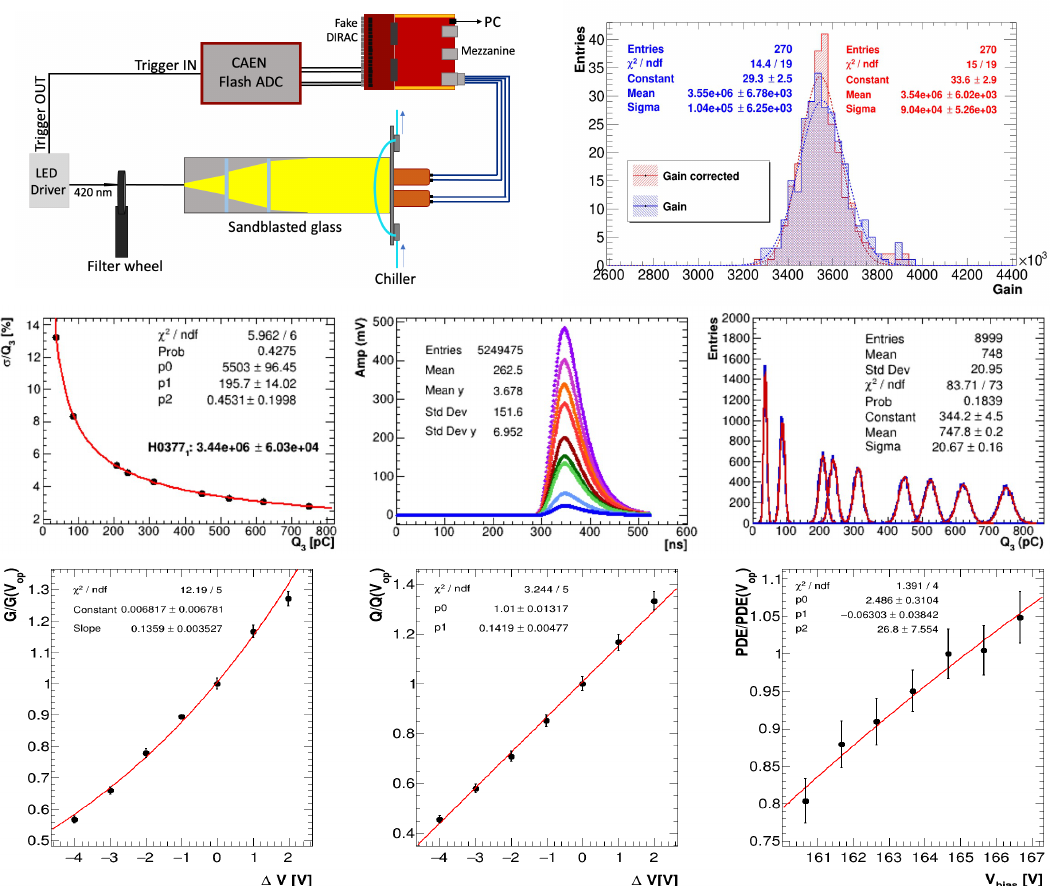
Figure 7. Top-left : test station architecture, including light pulse generator and attenuator. Top-right : distribution of ROU gains for a production batch. Centre : example of SiPM waveforms ( middle ) and charges ( right ) for various LED source amplitudes. Centre-left : σ Q / Q fit. Bottom : gain, charge and PDE scans at various